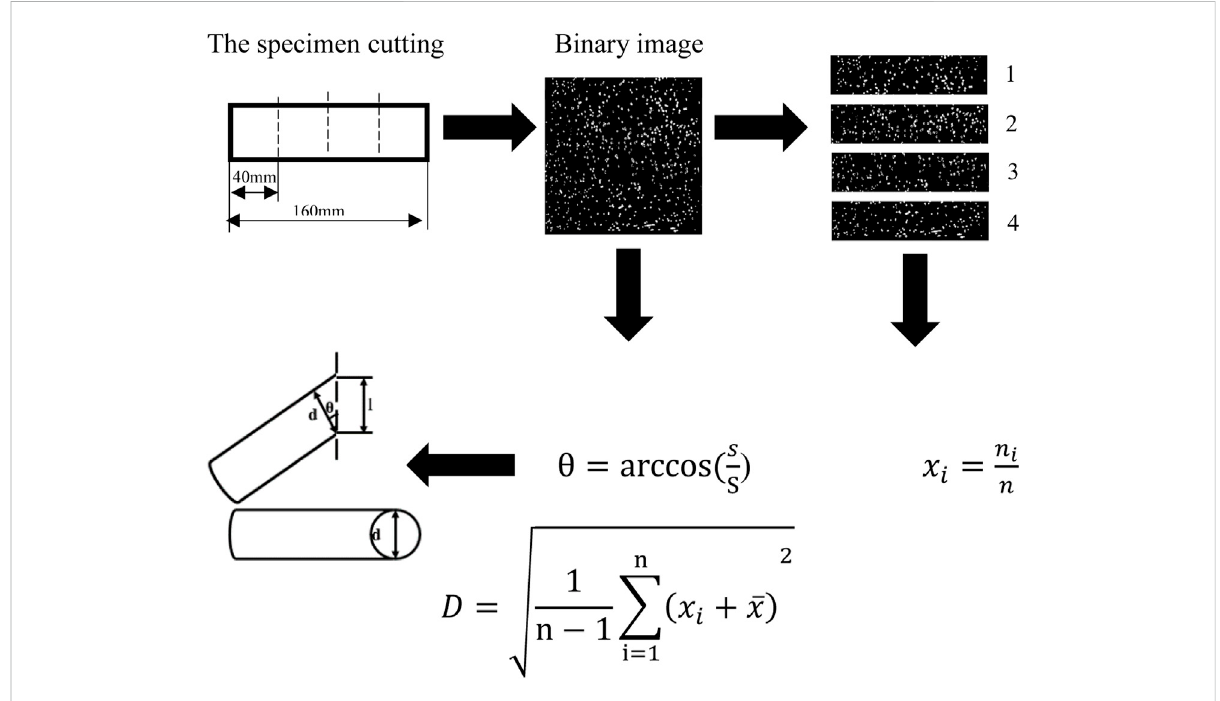
FIGURE 5 Image processing